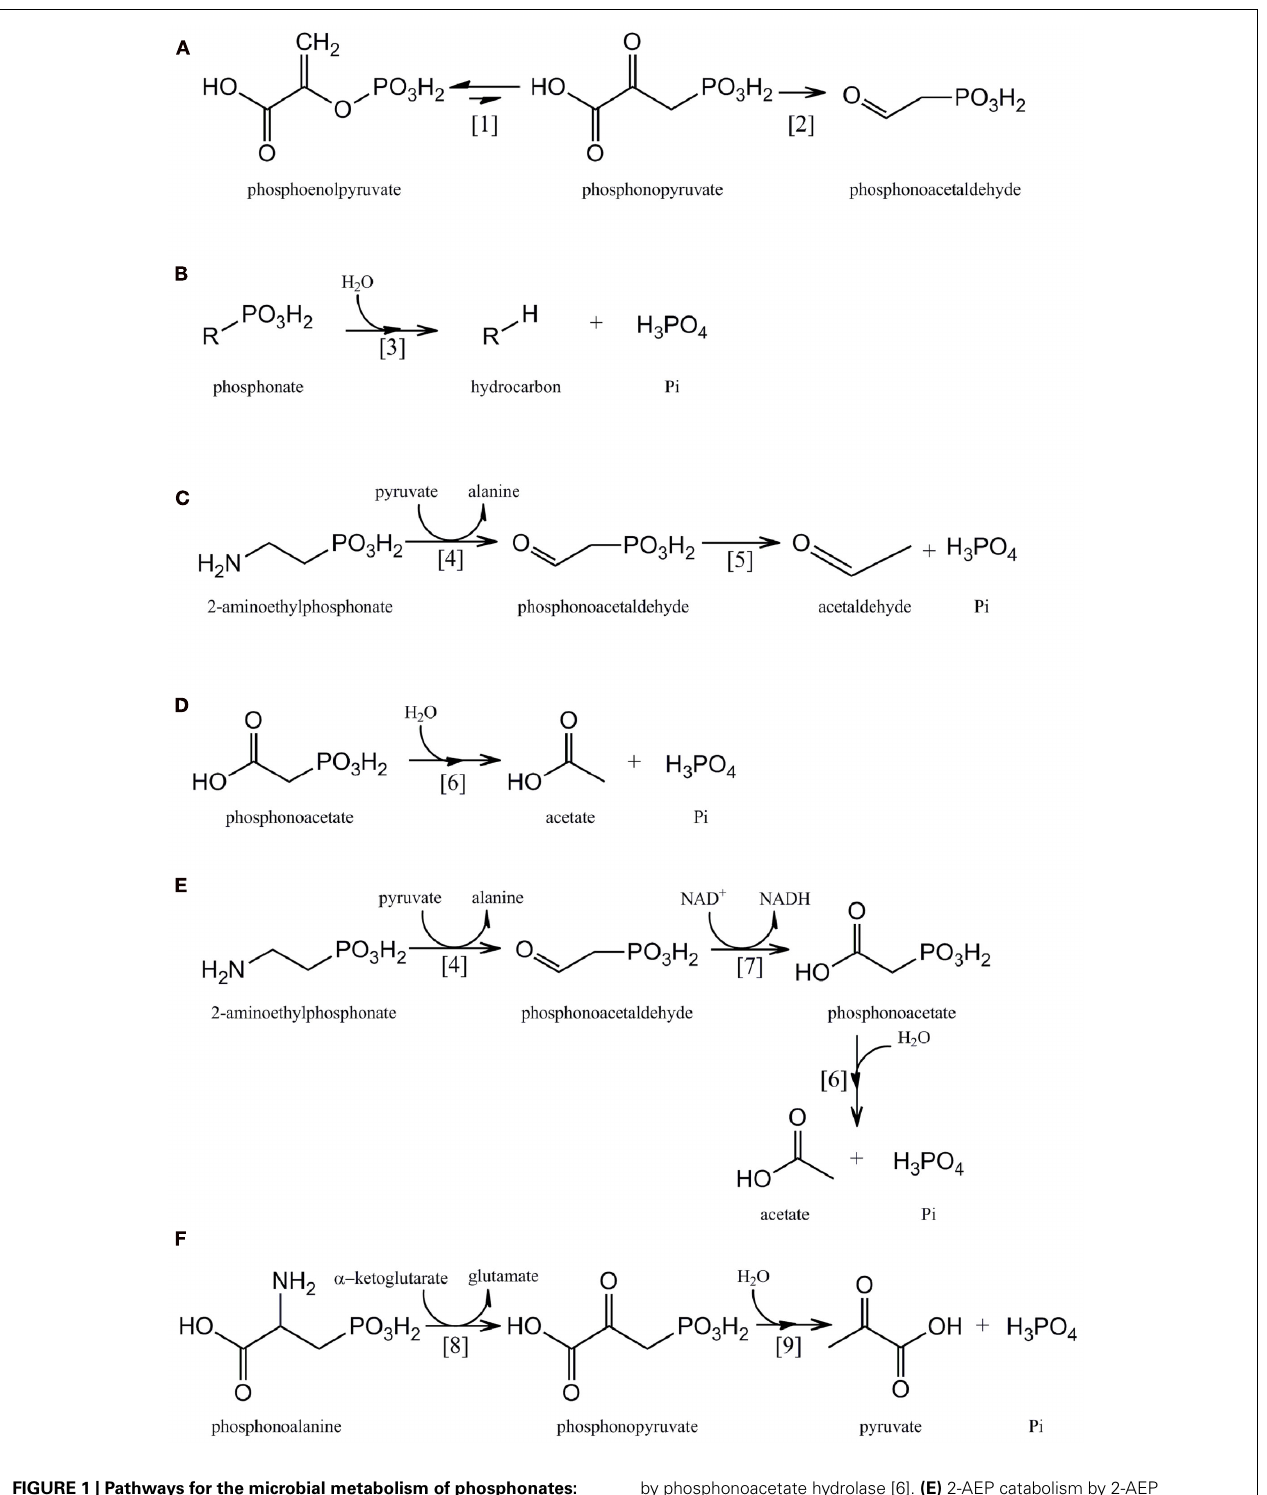
FIGURE 1 | Pathways for the microbial metabolism of phosphonates: (A) phosphonate biosynthesis by phosphoenolpyruvate phosphomutase [1] and phosphonopyruvate decarboxylase [2]. (B) C–P lyase [3] pathway. (C) 2-AEP catabolism by 2-AEP transaminase [4] and phosphonoacetaldehyde hydrolase [5]. (D) Phosphonoacetate catabolism